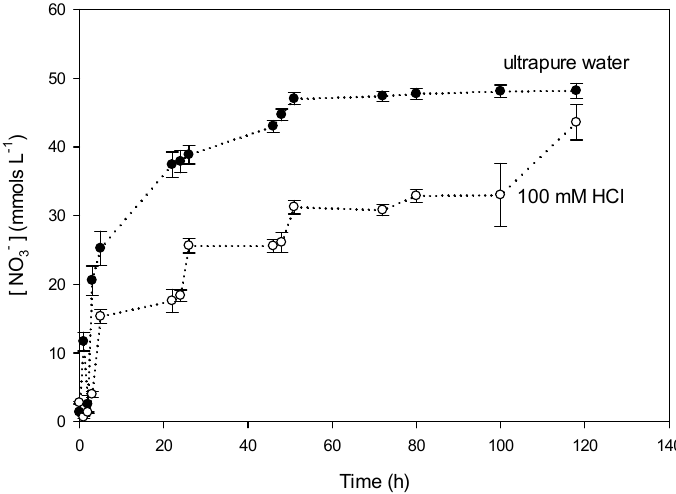
Figure 6. Evolution using PIM-8 of [NO 3 − ] in the receiving compartment in two different receiving phases: ultrapure water and 100 mM HCl.